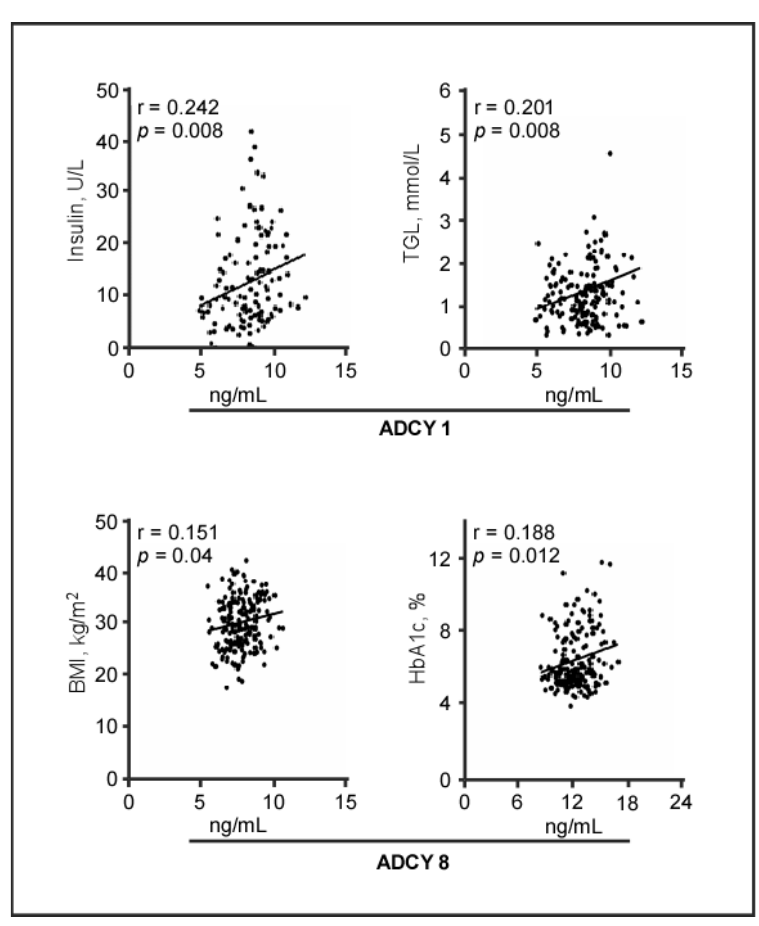
Figure 3. Correlation between plasma levels of ADCY isoforms and biochemical variables. Correlation coe ffi cients (r) were calculated using Pearson’s correlation. ADCY, adenylate cyclase; BMI, body mass index; HbA1c, glycated hemoglobin; r, correlation coe ffi cient; TGL,